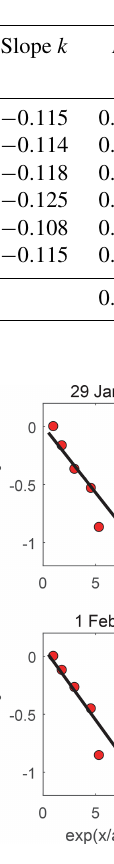
Table 2. Dispersion coefficient of salt intrusion in Humen estuary.